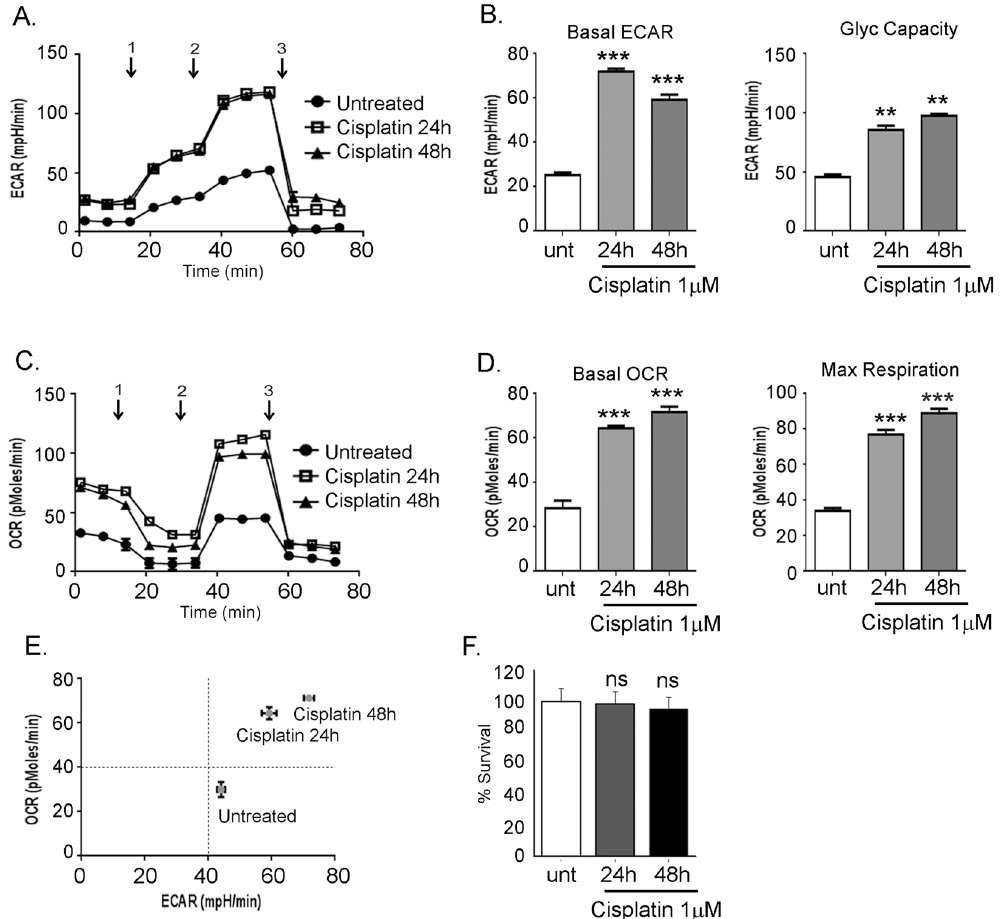
( A ) ECAR profile after (1) glucose (fuel for glycolysis), (2) oligomycin (an ATP synthase blocker) and (3) 2DG (an inhibitor of glycolysis) injections ( C ) OCR profile measured under similar conditions after (1) oligomycin (ATP synthase inhibitor), (2) FCCP (an electron transport chain uncoupler) and (3) rotenone (an inhibitor of electron transport chain) injections. ( B ) Basal glycolysis and glycolytic capacity is increased by cisplatin exposure. ( D ) Basal mitochondrial respiration and maximum respiration is increased by cisplatin exposure. ( E ) OCR: ECAR ration indicate a shift in bioenergetics phenotype from glycolytic to highly active metabolism after cisplatin treatment. ( F ) Cisplatin (1 uM) is non-toxic at the concentration used. All Seahorse experiments were carried out in triplicates and replicated thrice. *** p < 0.001, ** p < 0.01, NS: non-significant cisplatin treated compared to untreated. Abbreviations: ATP: adenosine triphosphatase; 2DG: 2-deoxyglucose; FCCP: carbonylcyanide-p-trifluoromethoxyphenyl hydrazine. OCR: Oxygen Consumption Rate; ECAR: Extracellular Acidification